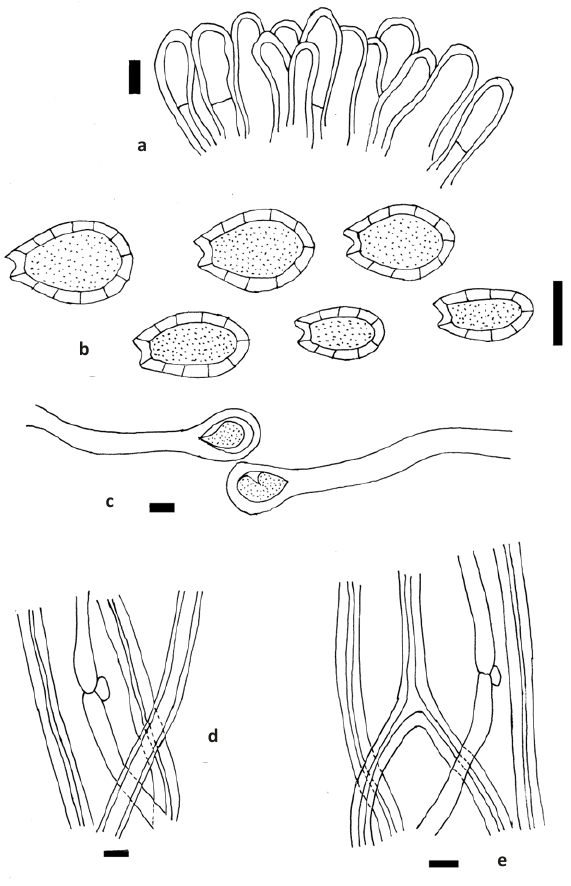
Figure 3. Ganoderma flexipes . a - hyphae of the cutis, b - basidiospores, c - chlamydospore, d - context hyphae, e - tube layer hyphae. Bars = 5µm. Drawing by R. Saha.